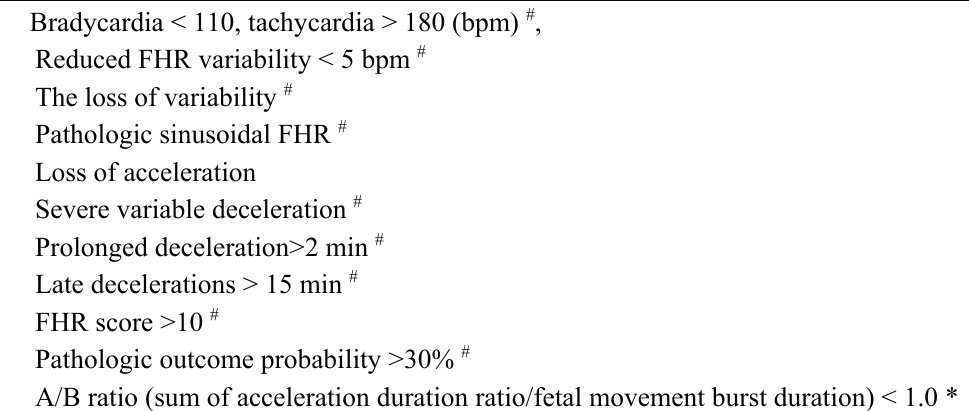
Table 2. Direct information items of fetal abnormalities to attending